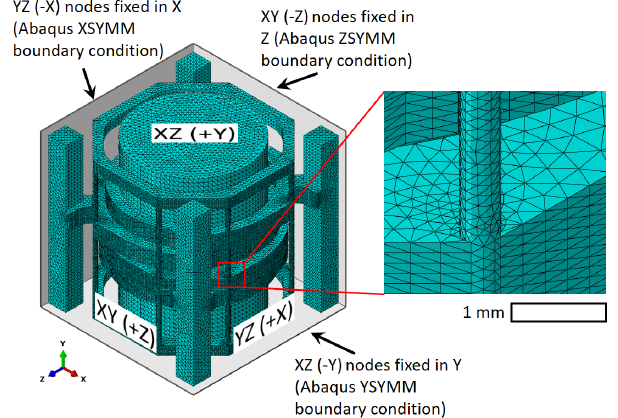
Figure 6. Representative example of the converged mesh of the low-CTE concept lattice unit cell and its boundary conditions applied on a lattice unit cell